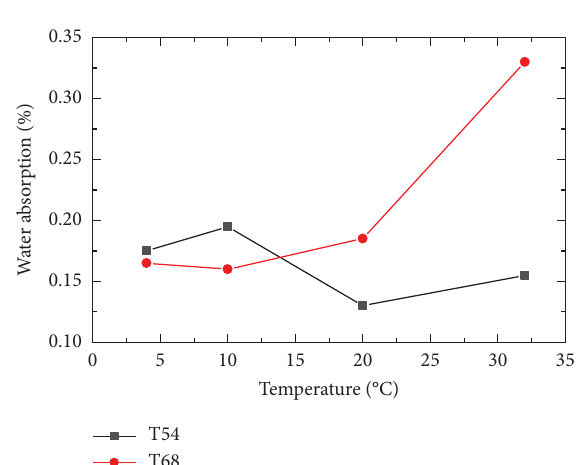
Figure 7: Water absorption vs. temperature.